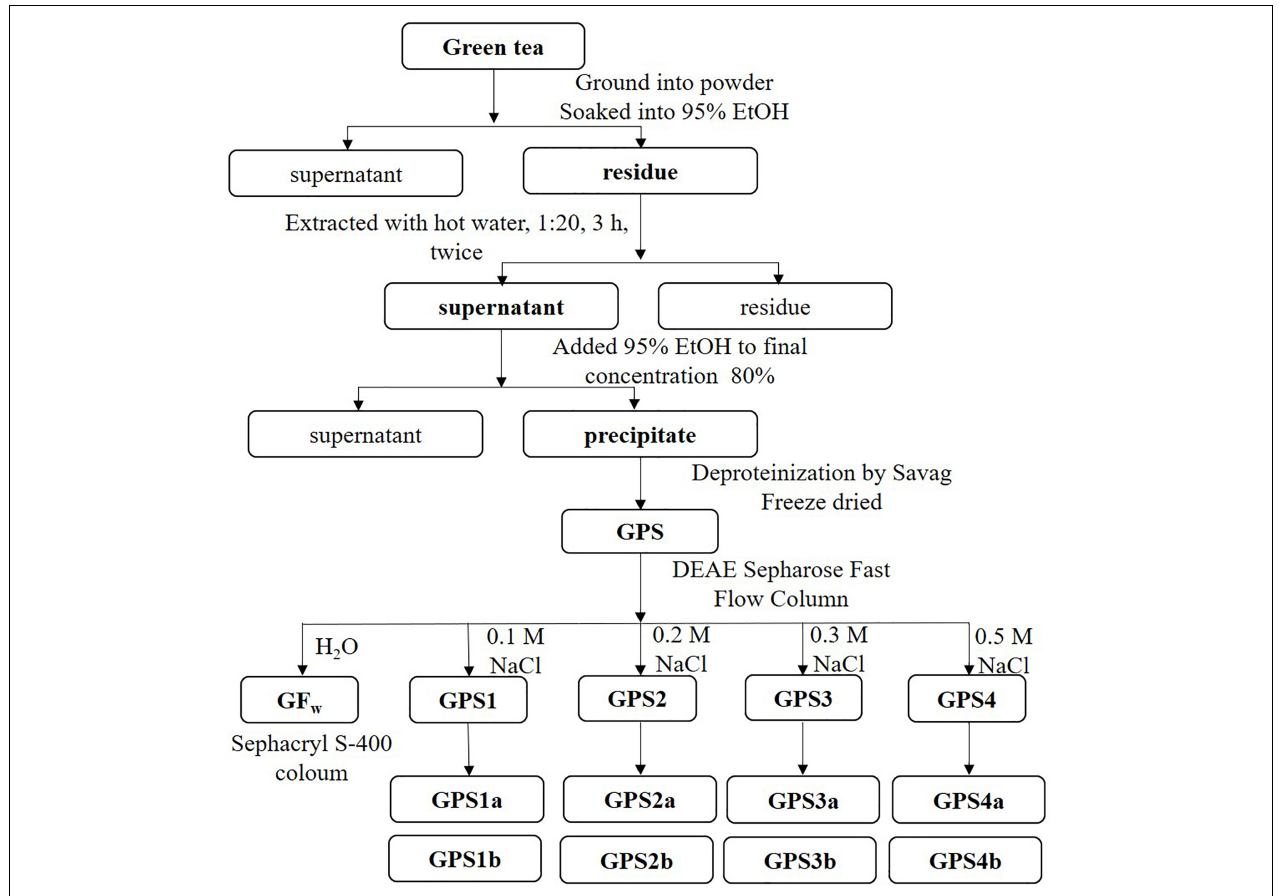
FIGURE 1 | Flowchart of the extraction and purification process of polysaccharides from Gougunao green